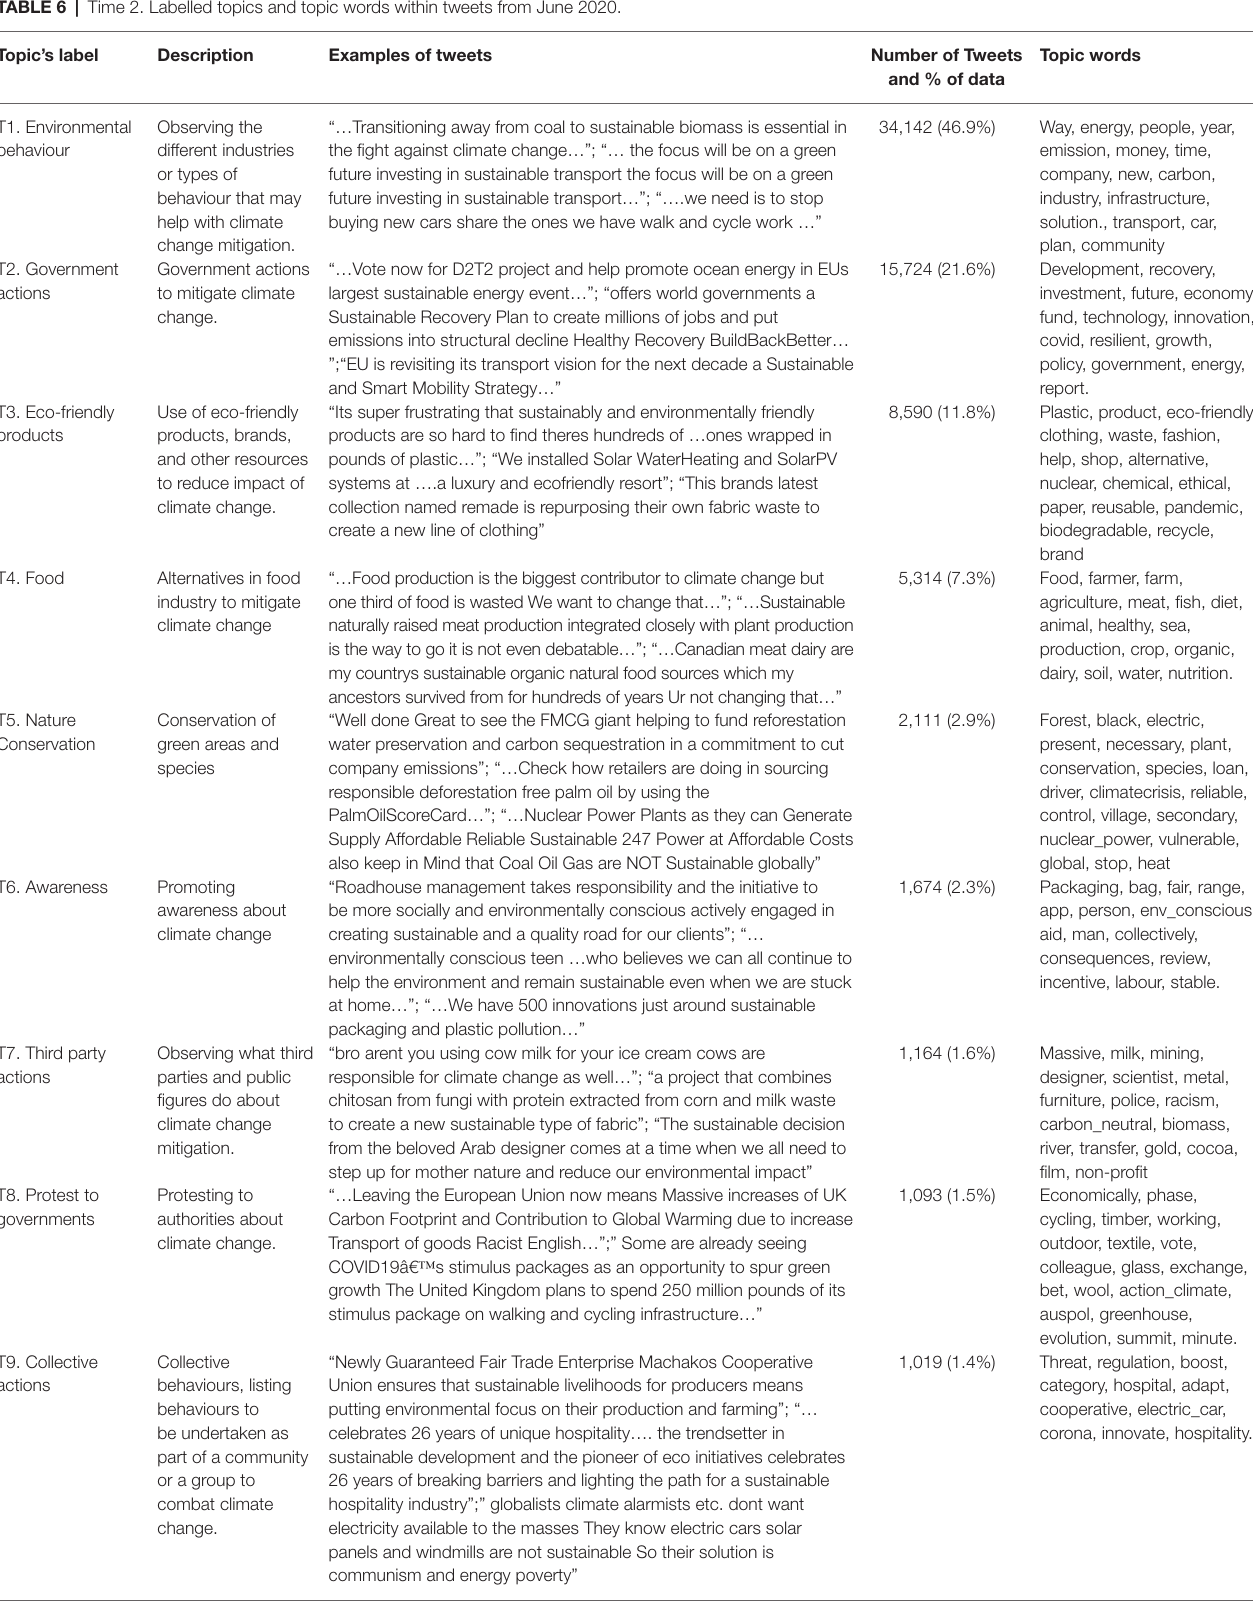
TABLE 6 | Time 2. Labelled topics and topic words within tweets from June 2020. Topic’s